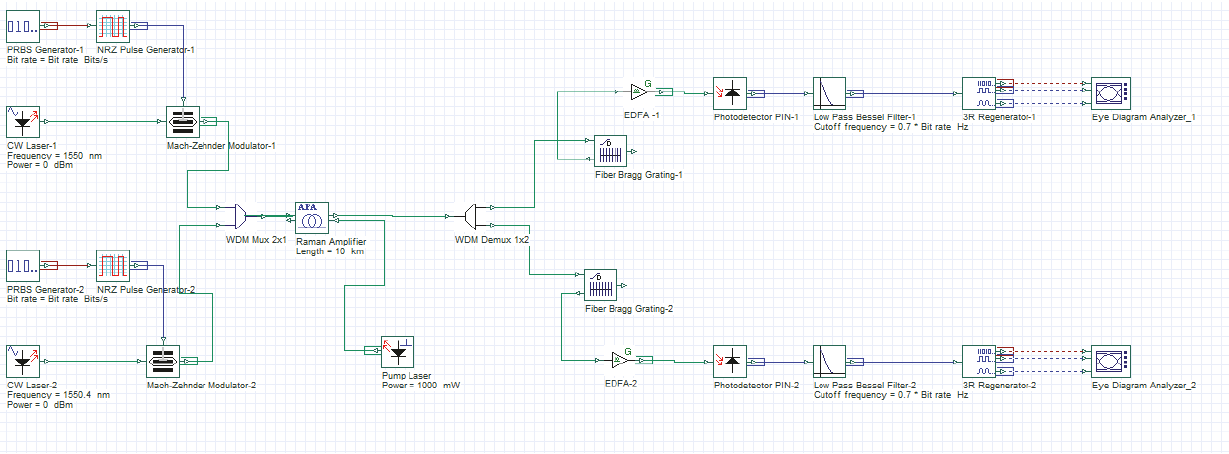
Figure 10: Fiber Raman amplifier for WDM system using FBG end